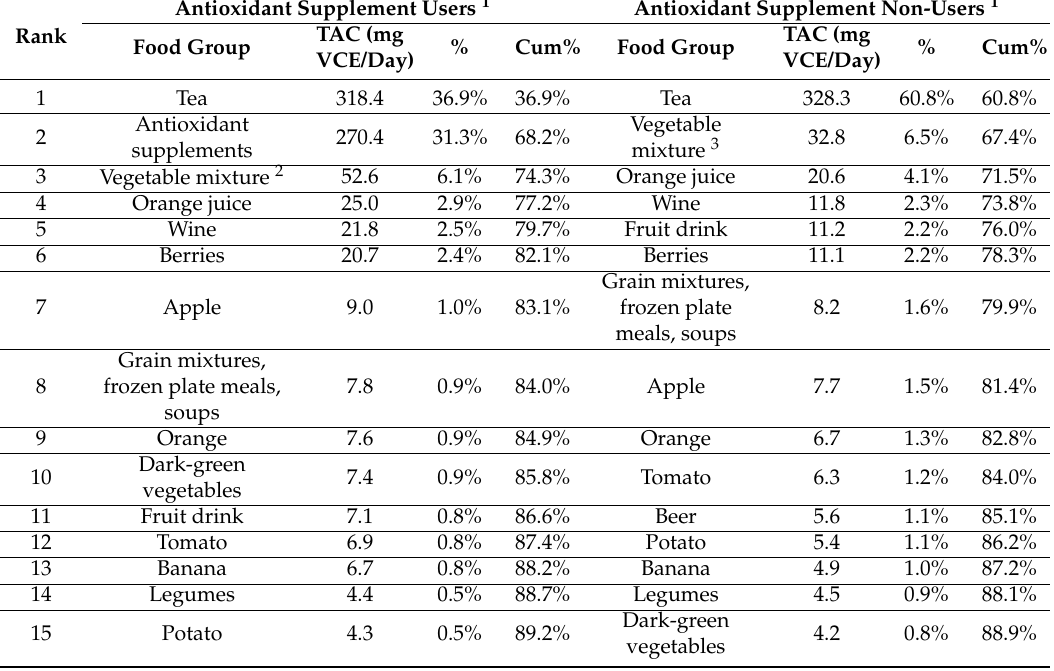
Table 3. Top sources contributing to total antioxidant capacity (TAC) of antioxidant supplement users and non-users among U.S. adults in the NHANES 2007–2012 ( n = 4039).